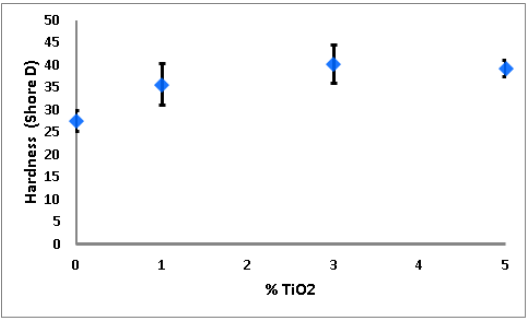
Fig. 5. Hardness of the APE/TiO